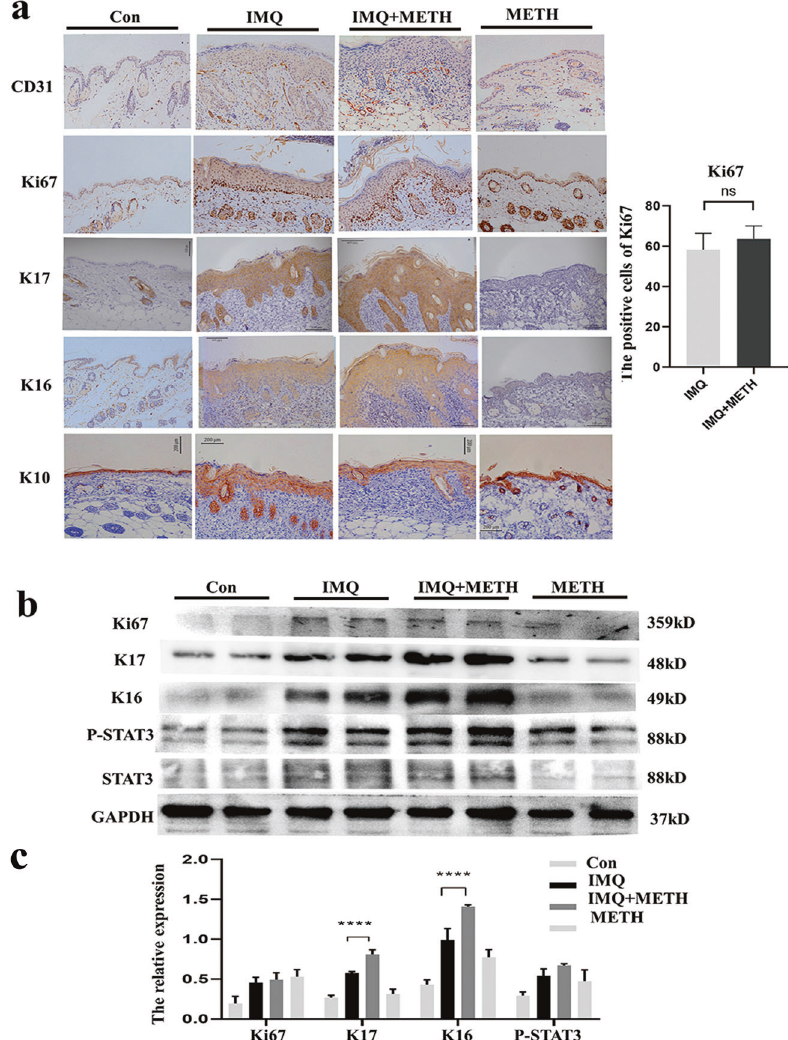
b The protein levels of Ki67, K17, K16, STAT3, and P-STAT3 in skin lesion were measured by western blot assay. c The relative protein levels were accessed by image J